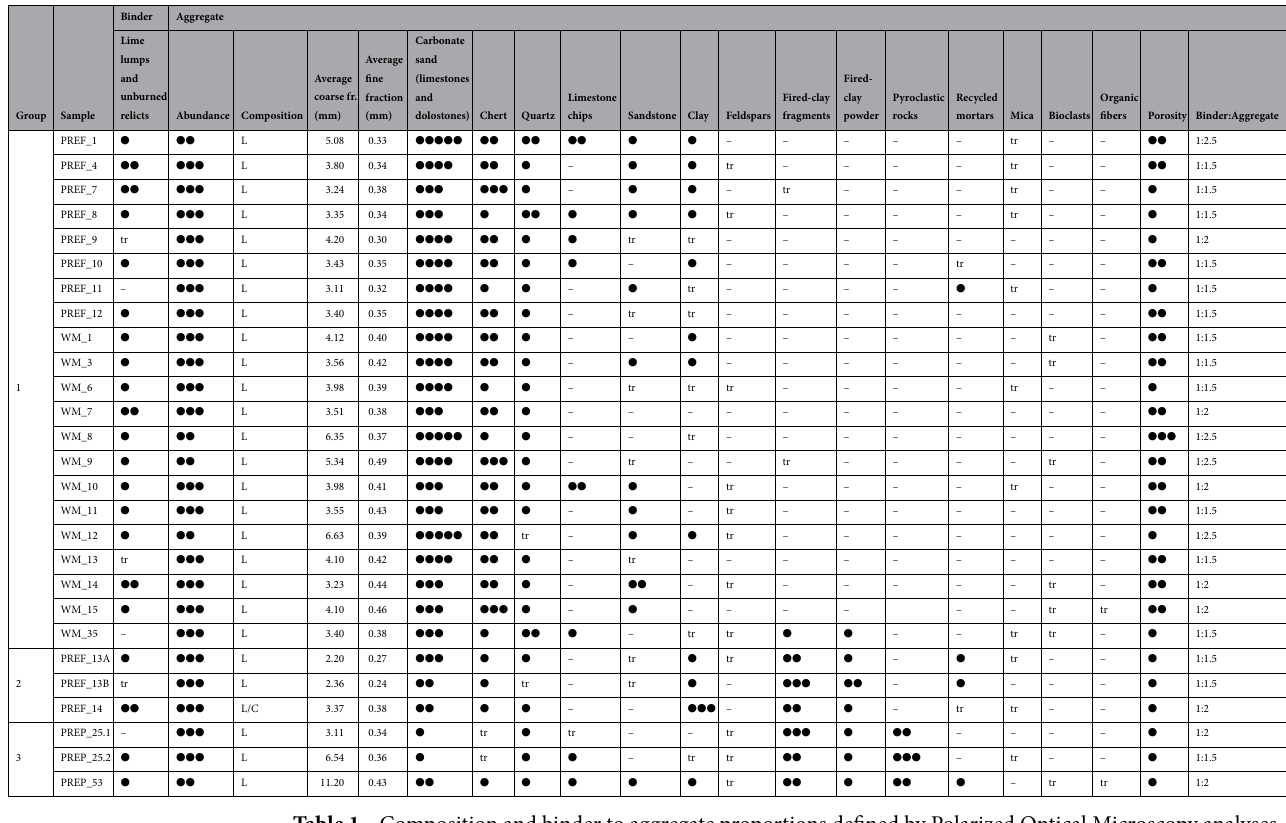
Table 1. Composition and binder to aggregate proportions defined by Polarized Optical Microscopy analyses on thin sections of the samples collected from the theatre. Legend: ●●●●● : extremely abundant (>